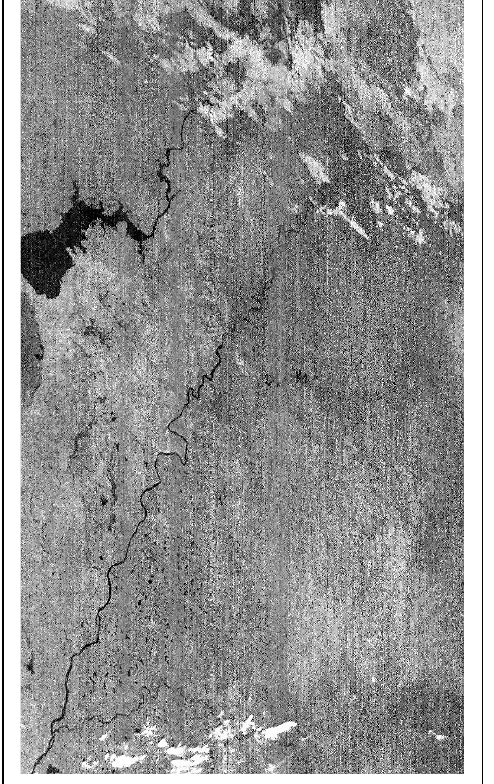
Figure 6: Non calibrated image of Mesopotamia Sector (Argentina), from NIRST .(11 μ m).